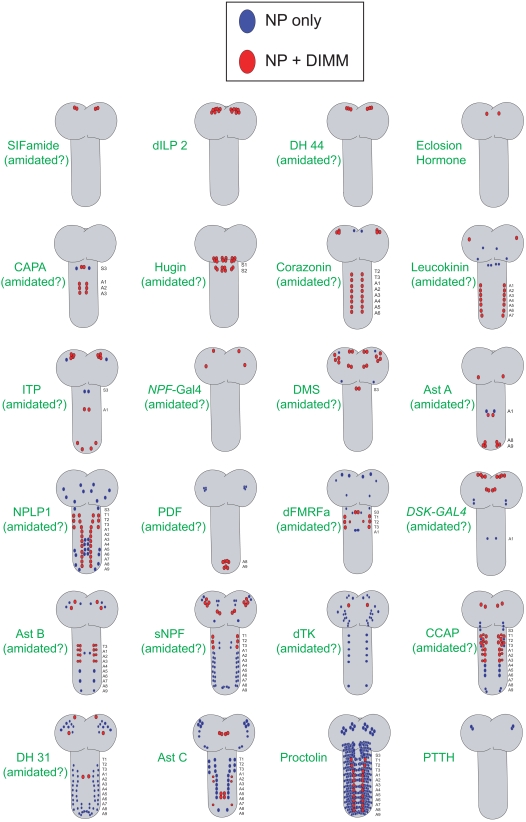
Schematics describing the distribution of cells scored positive for each of the 24 peptide markers found in the 100 hr AEL larval CNS.If the peptides are potentially amidated, this is noted below each marker name in parentheses (amidated). Blue cells are marked by the peptide marker, but lack DIMM staining; Red cells co-express DIMM. The proctolin schematic does not show the complete complement of ∼400 proctolin-immunoreactive neurons. Schematics are distributed with ones showing greater percentages of DIMM co-expression are towards to the top of the figure and ones showing lesser percentages are towards the bottom.